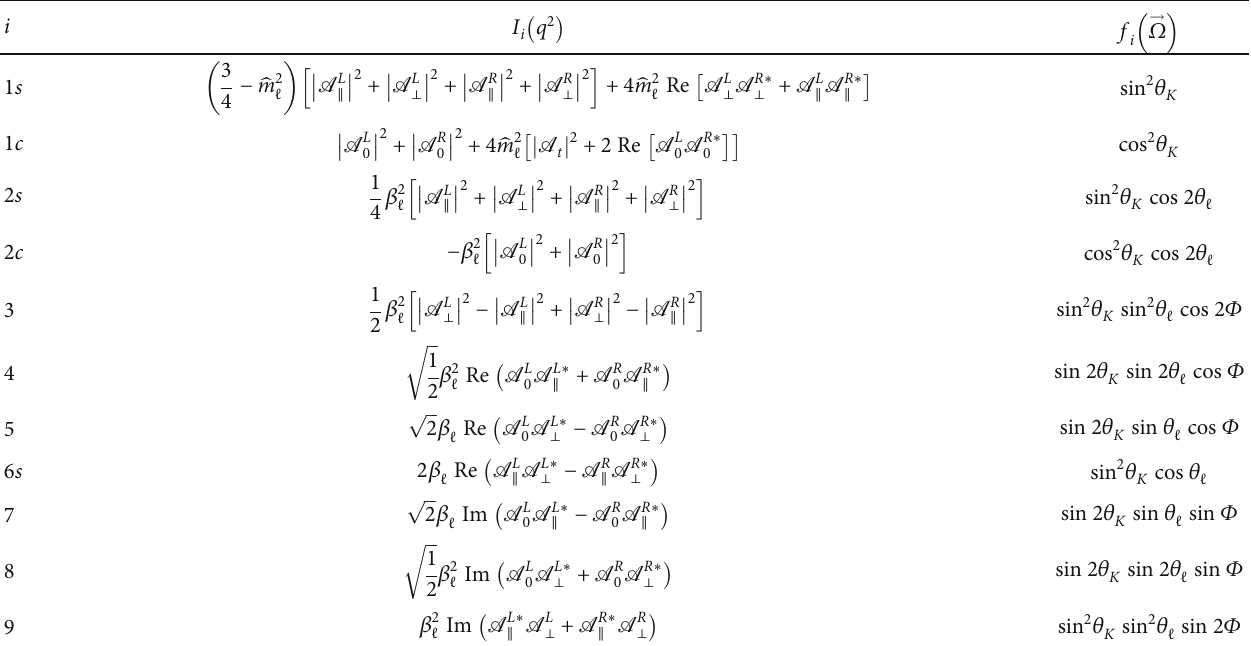
! ð q 2 Þ and f ð Ω Þ appeared in Equation i i